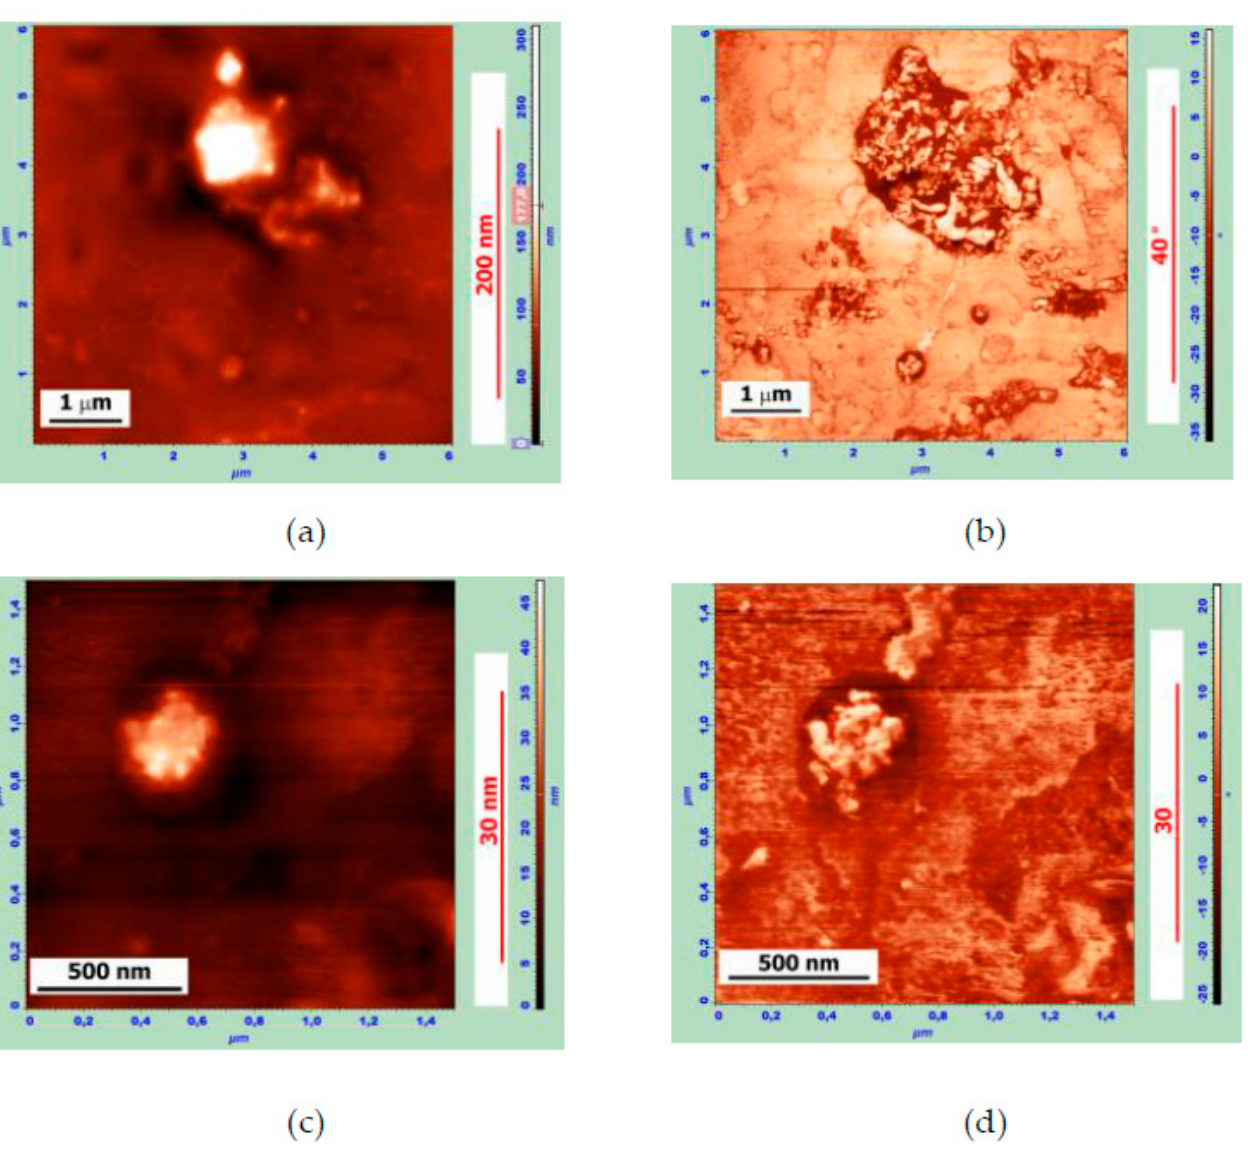
Figure 5. AFM images of the surface of the sample of the MB with composition of 85 wt.% Bit-A +15 wt.% hybrid powder, obtained 2 days after sample preparation. Topography (left), phase image (right): ( a , b )—6 × 6 μ m, ( a ) Z-coordinate—310 nm; ( c , d )—1.4 × 1.4 μ m, ( c ) Z-coordinate—50 nm. The AFM images of thin films observed on the surface of the MB with a 90 wt.%